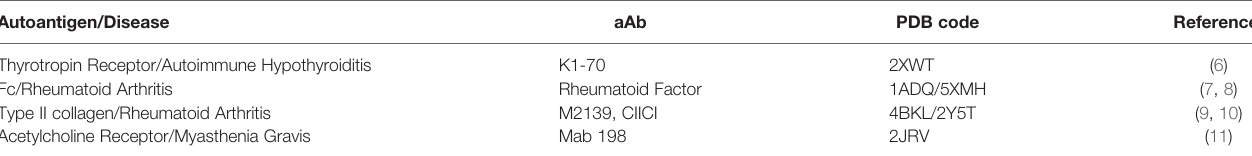
TABLE 1 | Experimental 3D structures of autoantibody : Autoantigen complexes. Autoantigen/Disease